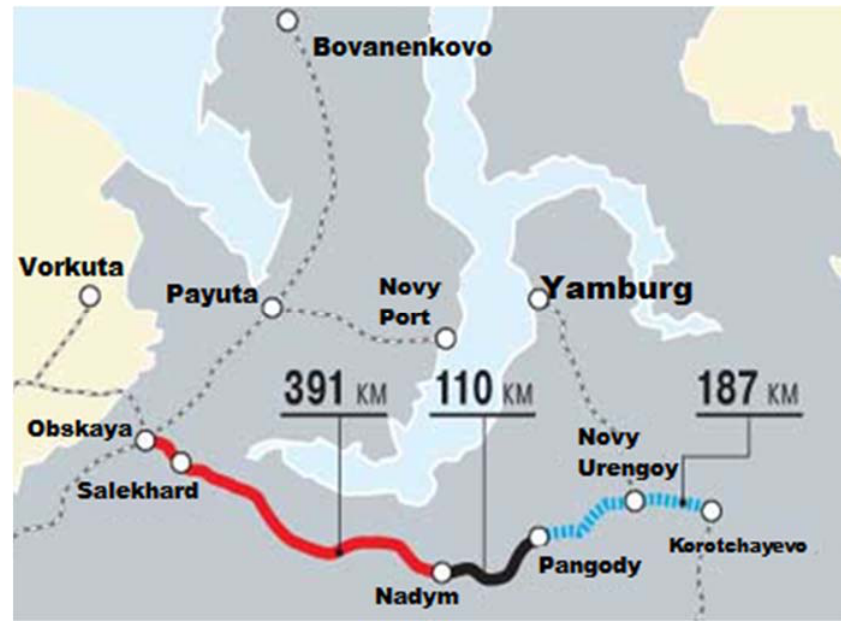
Figure 1. The construction plan for geotechnical structures in the Arctic